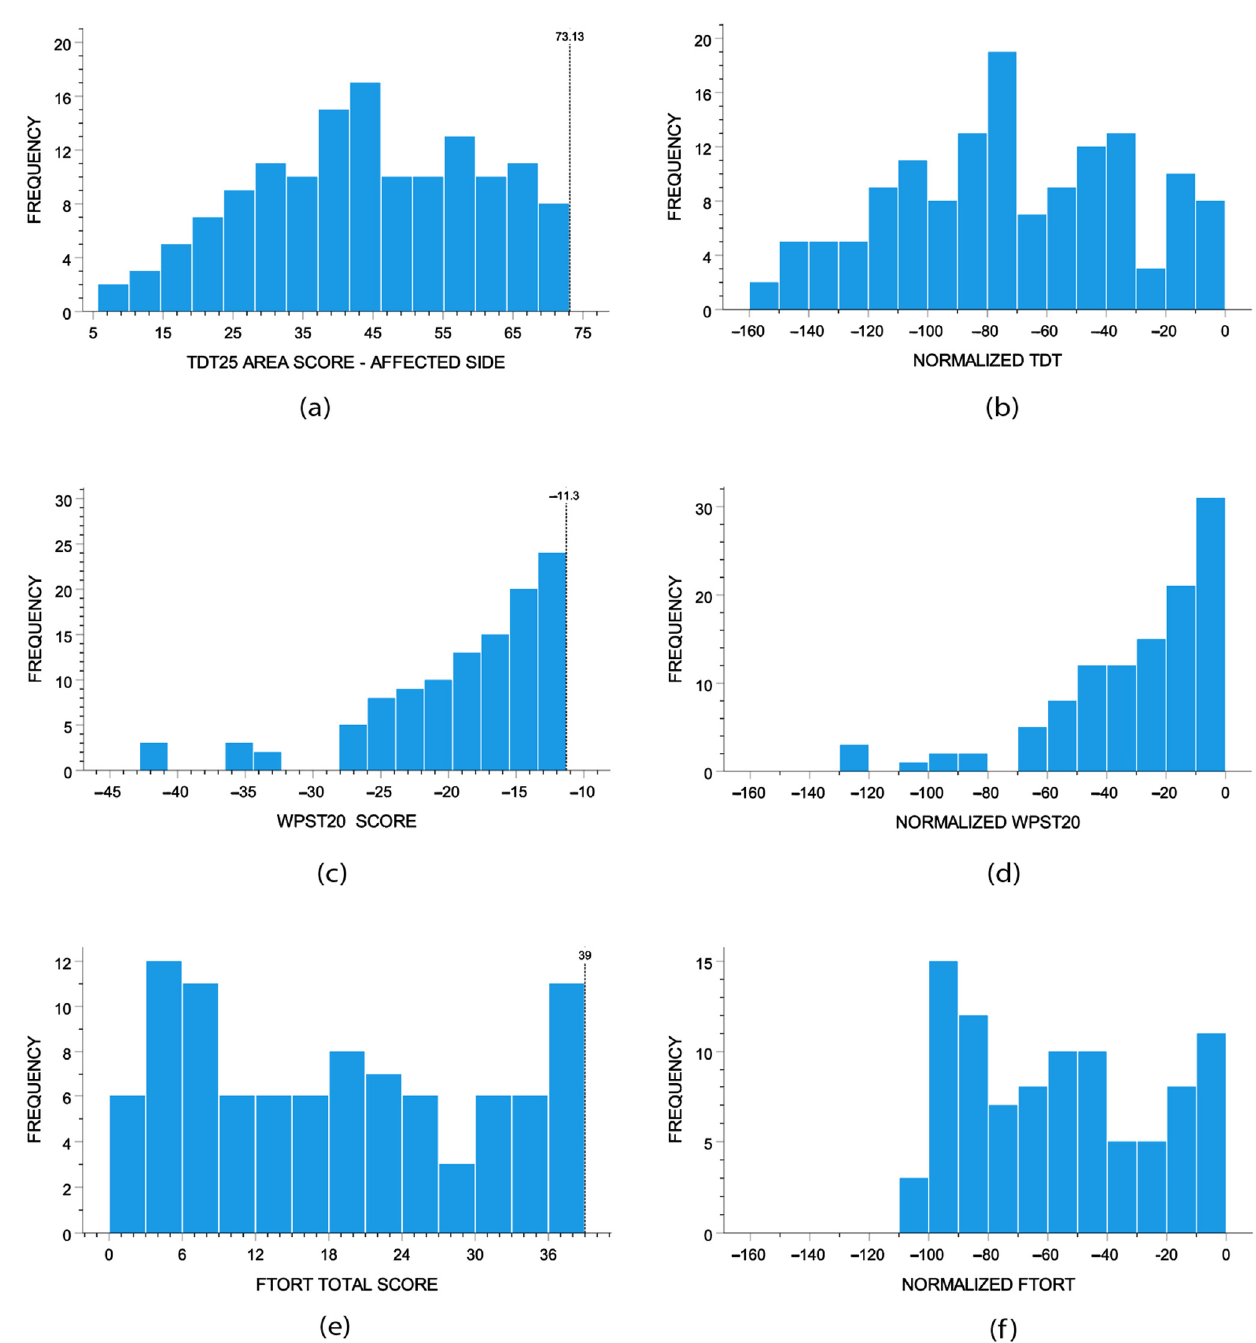
Figure 6. Histograms of untransformed raw scores (left panels; ( a , c , e )) and normalized impaired scores (right panels; ( b , d , f )) on the TDT25, WPST20 and fTORT collected at baseline from stroke survivors. The criterion of abnormality for the TDT25 is 73.13 PMA ( a ); for the WPST, 11.3 average error ( c ); and for the fTORT, 39 total score (e). Normalized impairment scores ( b , d , f ) start at zero.